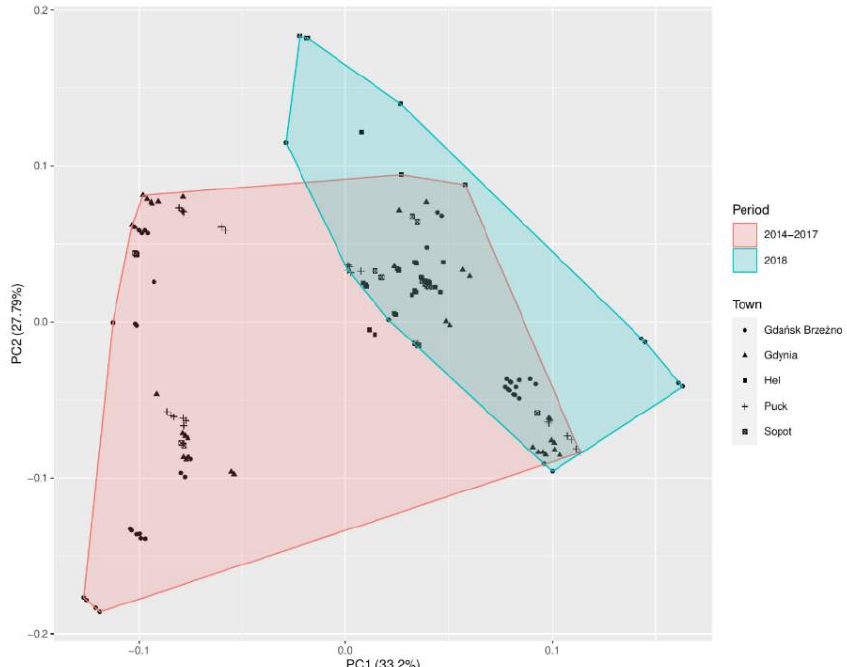
Figure 4. Principal component analysis (PCA) of Penicillium sp. detected in air samples in the seaside towns (Hel, Puck, Gdynia, Sopot, and Gdańsk Brzeźno). Here the plot score of the first two principal components is reported. It contains almost 60.98% of the explained variance. Two clusters can be distinguished: The red one is composed in the study period of 2014–2017 and the blue cluster in